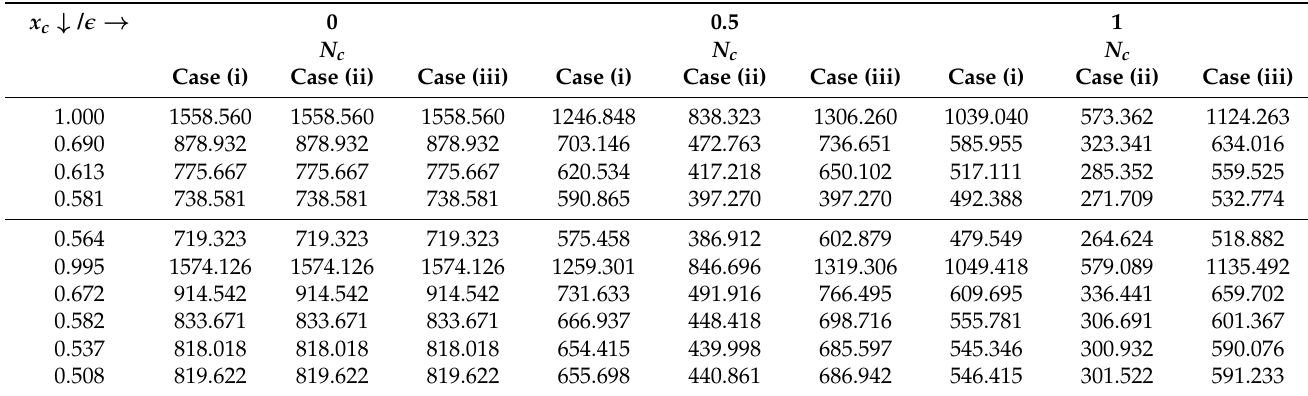
Table 5. N c for the cases (i), (ii), and (iii), for different values of x c and (cid:101)